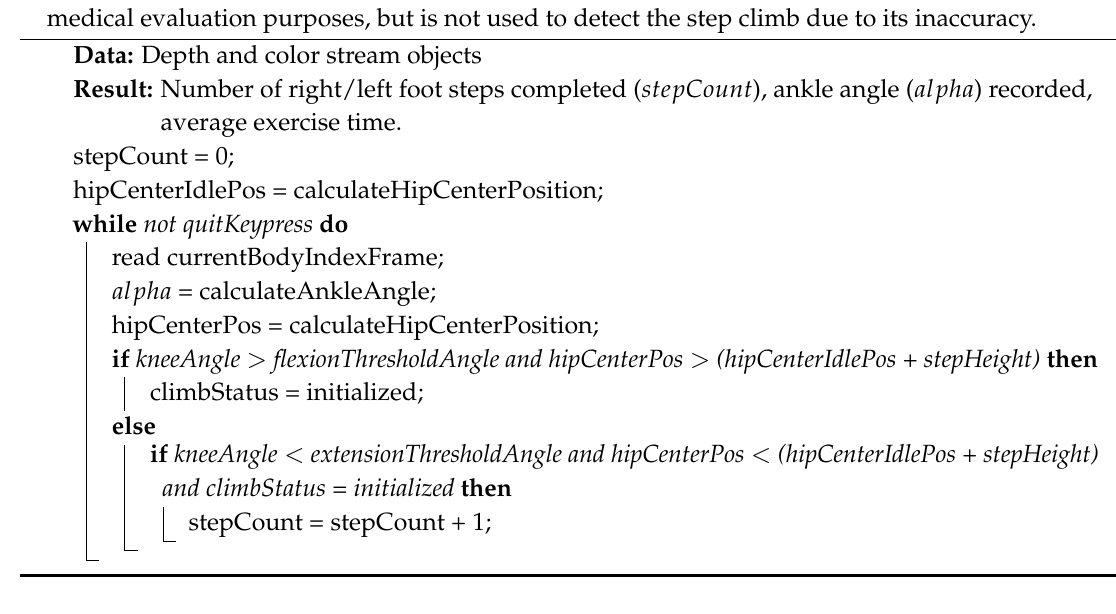
Algorithm 2: Step count algorithm. The step detection is based on (a) the general rise of the body, taking the hip center as a reference and (b) the sequential flexion and extension of the knees. The ankle angle history alpha is recorded throughout the duration of the exercise for medical evaluation purposes, but is not used to detect the step climb due to its inaccuracy.